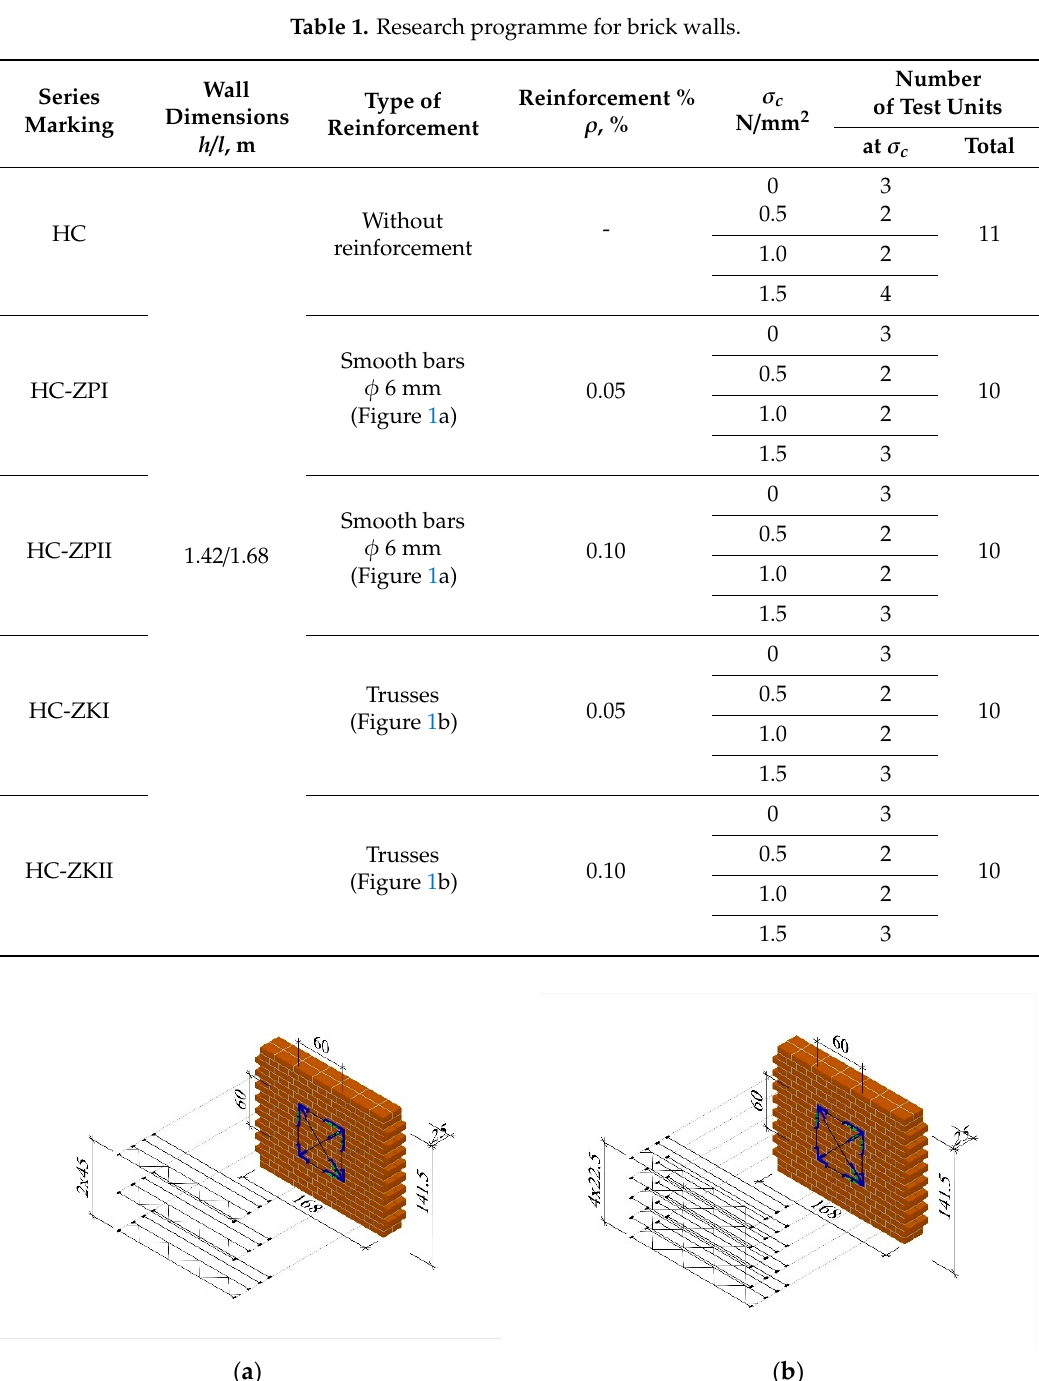
Figure 2. Geometry of solid brick models: (a) reinforced with bars and trusses of series HC-ZPI and HC-ZKI ( ρ = 0.05%) and (b) reinforced with bars and trusses of series HC-ZPII and HC-ZKII ( ρ = 0.10%), dimensions are in centimeters.